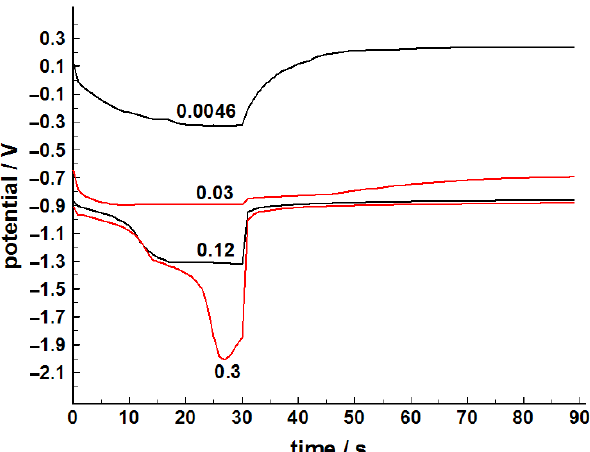
Figure 2. Examples of chronopotentiograms recorded during cathodic polarization of tungsten electrode in 3LiCl–2KCl–ZrCl 4 melts (2.14 wt. % Zr, 532 °C). Polarization current density (A/cm 2 ) is given on the graph for each set of data. Potentials vs. Ag/AgCl reference electrode.